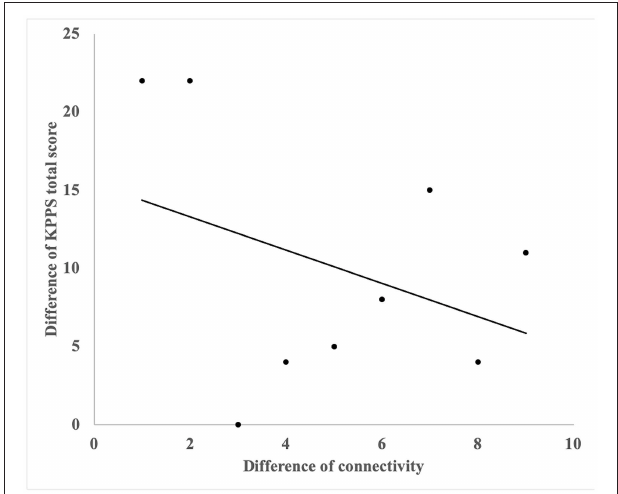
FIGURE 3 | The correlation with reduction of KPPS and changes of functional connectivity of right precentral gyrus and left middle frontal gyrus. A significant correlation was noted between the changes in functional connectivity and changes in total KPPS score in the acupuncture group. The involved connection was between the left middle temporal gyrus and the right precentral gyrus ( R = − 0.698, P = 0.037).